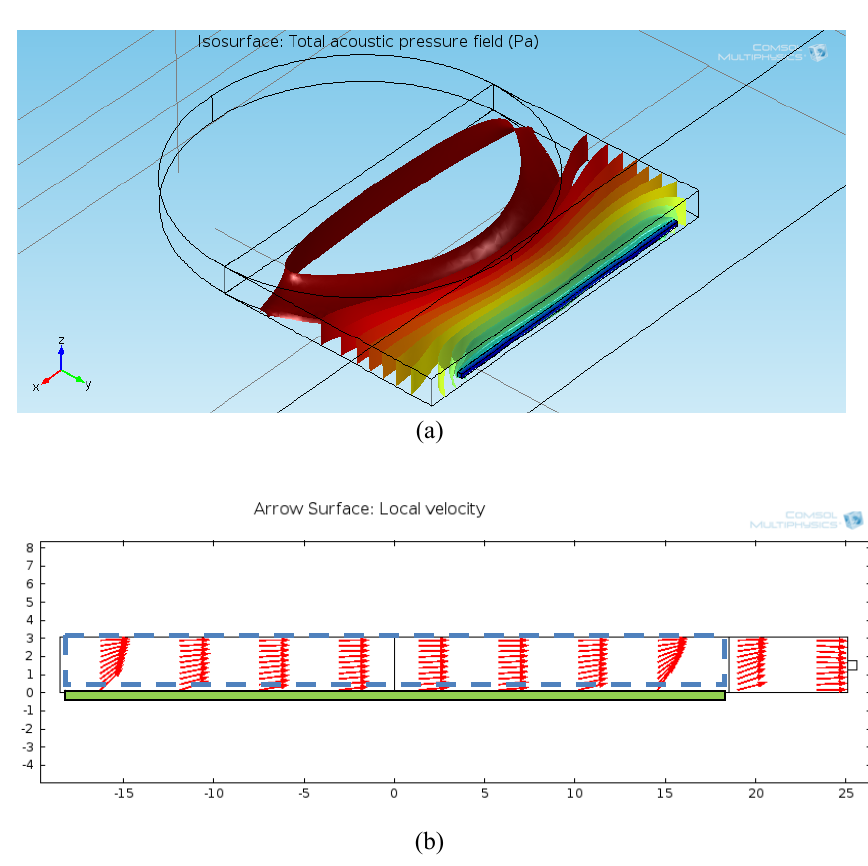
Fig. 11 COMSOL simulation inside a synthetic-jet actuator with a side-mounted PZT